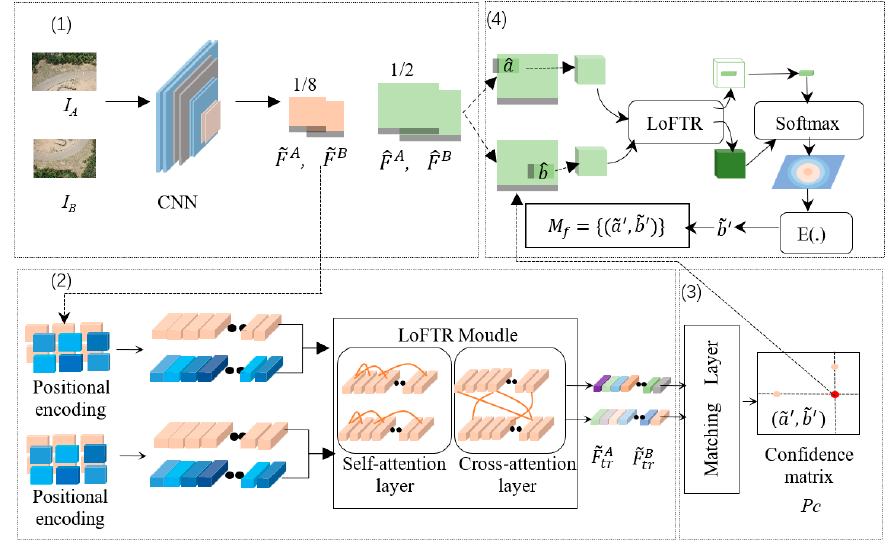
Figure 4. Architecture of the local feature transformer (LoFTR) model.